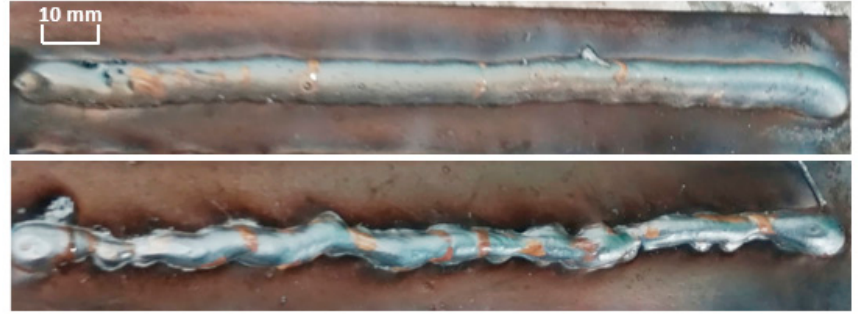
Figure 6. Manual welding results of a professional ( above ) and unskilled welder ( below ).